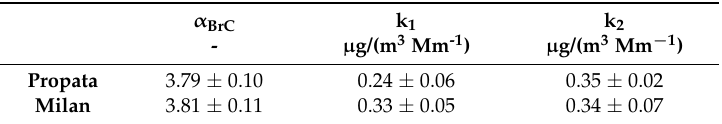
Figure 7. α BrC and associated fit uncertainty for the Milan dataset. Date and time referring to the beginning of the sampling are reported on the x-axis. Table 1. Summary of values and standard error for α BrC in samples with relative uncertainties <3%, k 1 , and k 2 .